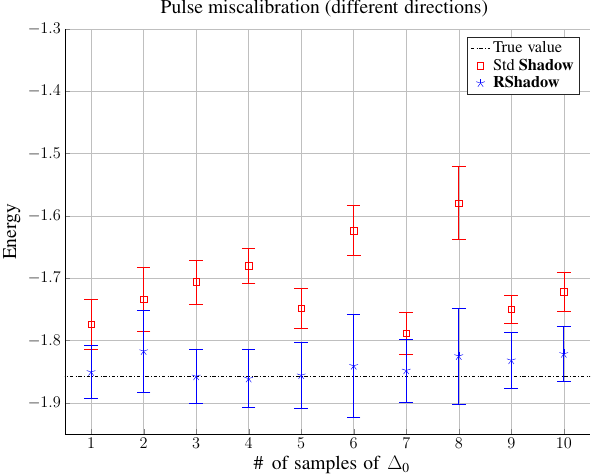
FIG. 10. Ground-state energy estimation of H 2 with pulse mis- calibration noise. Here we choose (cid:11) 0 = 0.1 π × ( v 1 X + v 2 Y + v 3 Z ) , where each different label of the x axis corresponds to a different sample of v given in Table